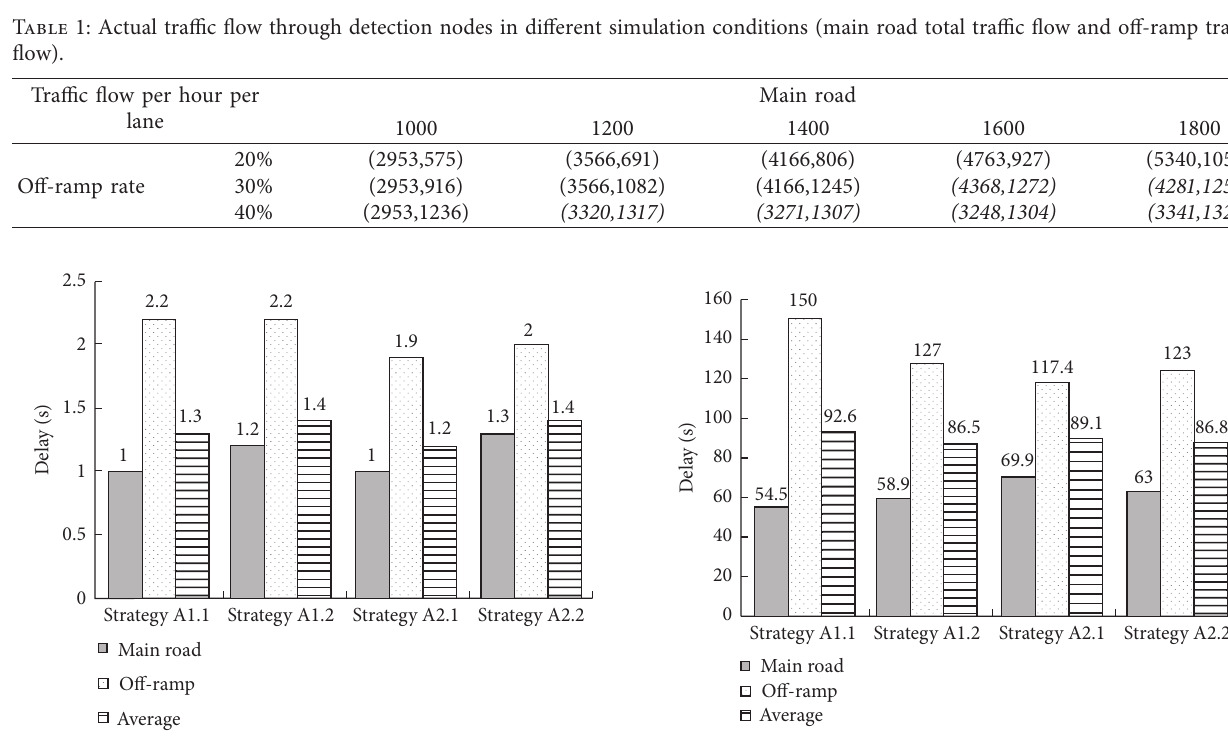
Figure 9: Vehicle delays comparison with main road flow 1000veh/h/lane and off-ramp rate 20%.